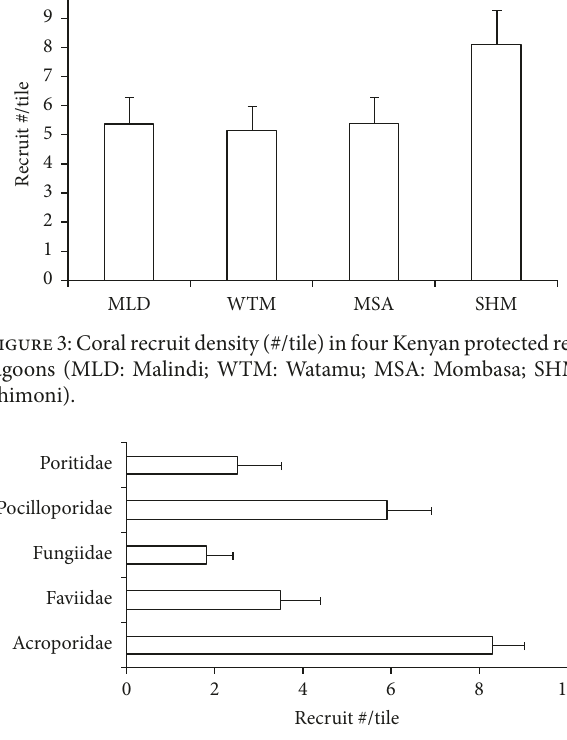
Figure 4: Composition of coral recruits (family) settling on experi- mental tiles deployed in Kenyan protected reef